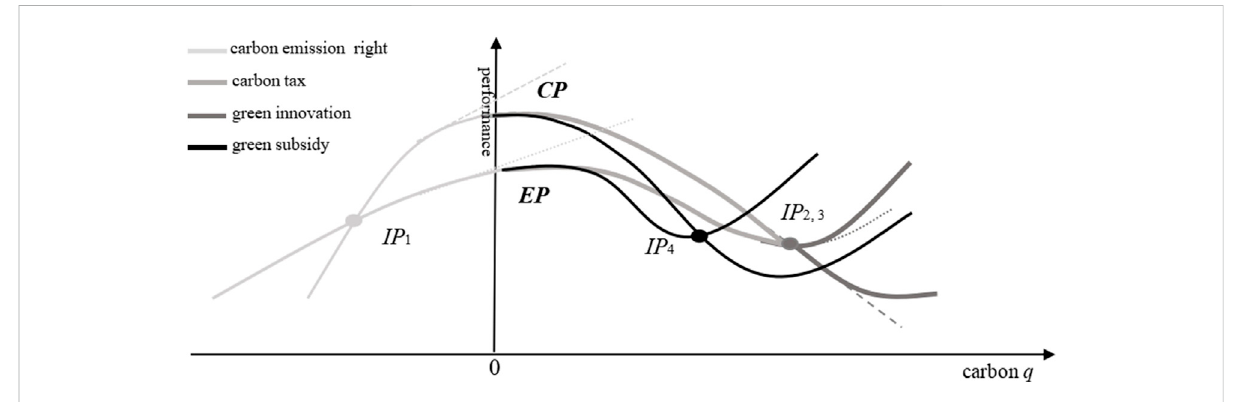
FIGURE 5 Economic analysis of carbon